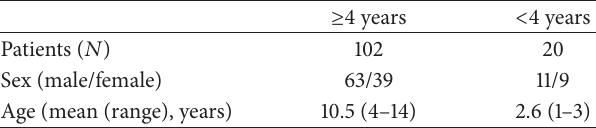
Table 1: Patient